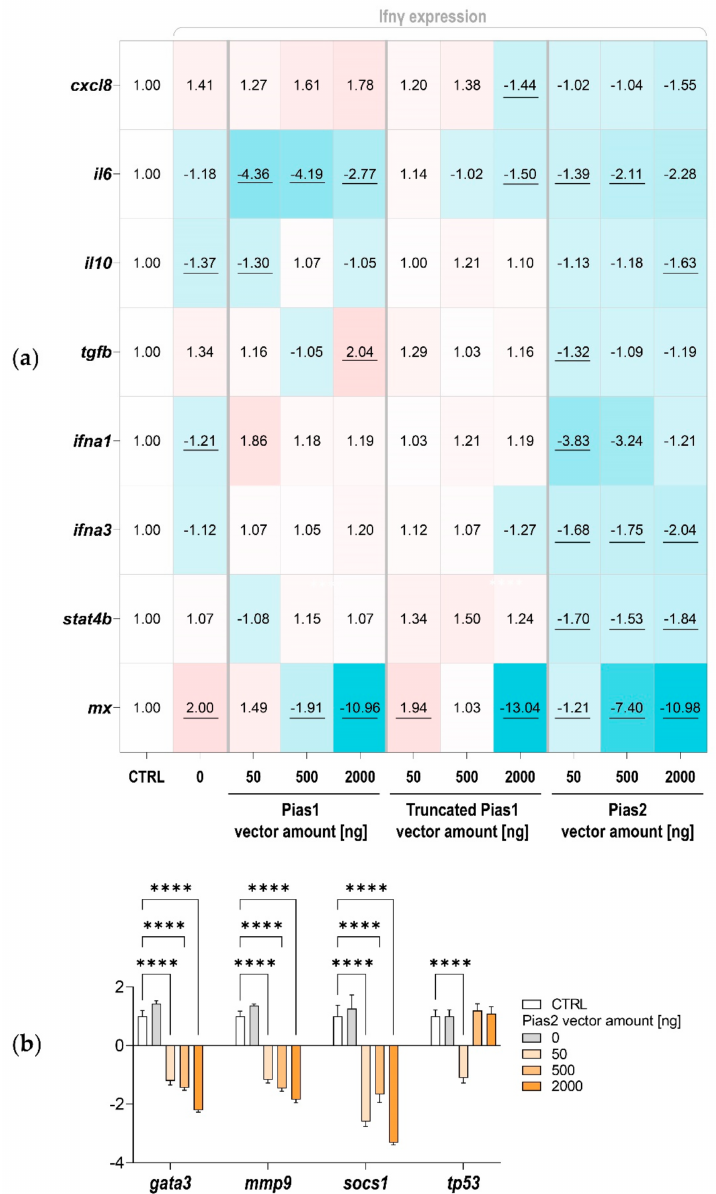
Figure 9. Expression profiling of pias -overexpressing CHSE-214 cells. ( a ) The heatmap and ( b ) bar chart illustrate the averaged fold-change values of the mRNA concentrations measured in cells transfected without (CTRL, set as 1.0) or with the ifn γ -expression vector (0 ng pias vector amount) together with pias -expression vectors (as indicated). The quantified transcripts are listed as gene symbols. All expression values shown in ( a , b ) were normalised against the geometric mean of two reference genes. Significantly different FC values compared to CTRL are underlined in ( a ). Statistical significance compared with the control group was assessed in ( b ) using one-way ANOVA (****, p < 0.0001); standard error of the mean (SEM) is